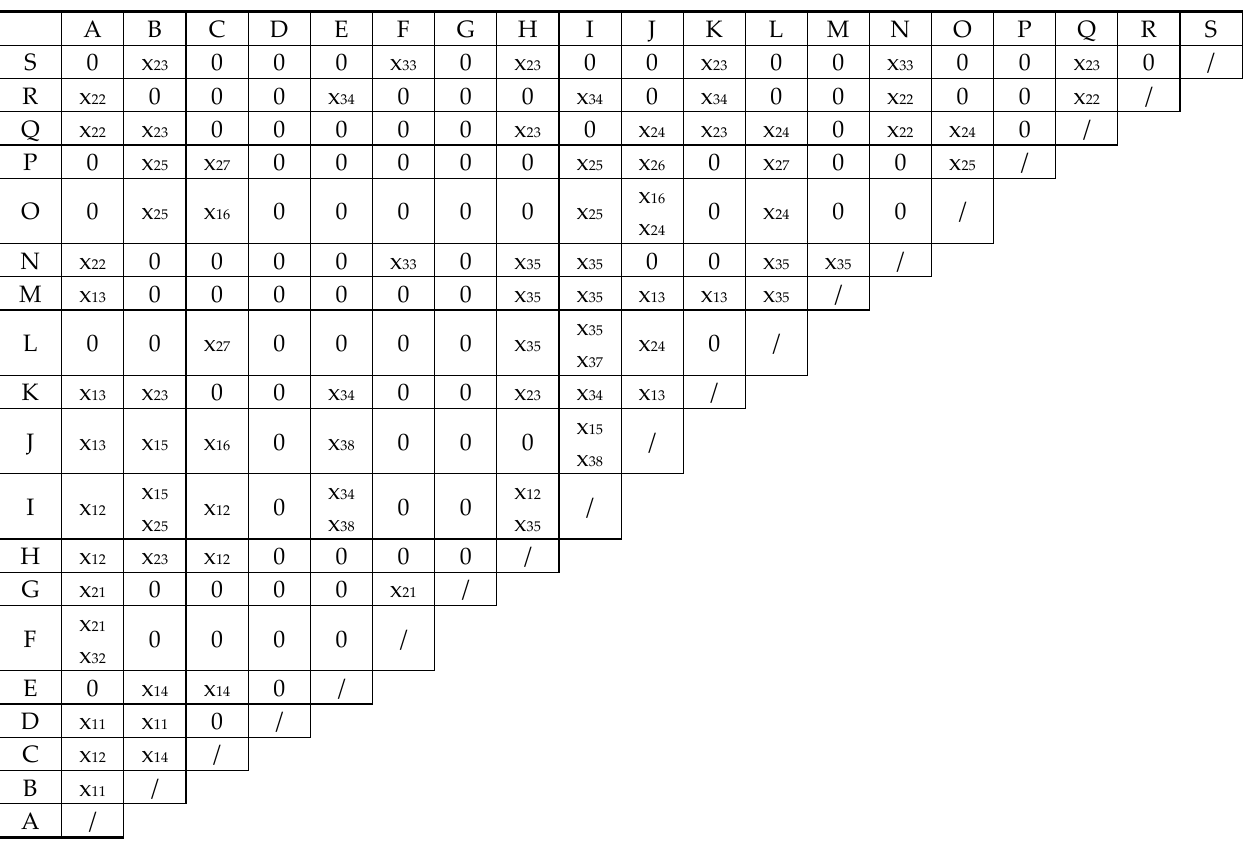
Figure 4. Connectivity table of urban agglomeration corridors. Table 1. Detailed information about urban agglomerations and corridors.